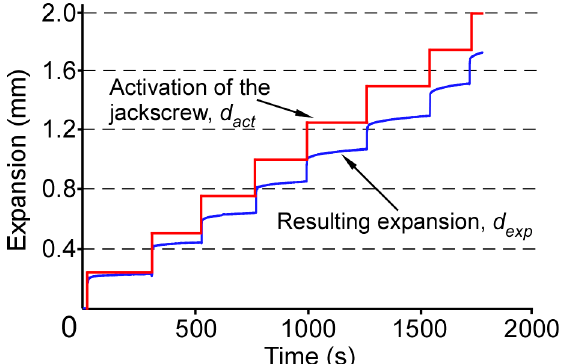
Figure 5. Comparison of the activation of the jackscrew ( d act ) and resulting expansion ( d exp ) as a function of time for eight turns of the jackscrew (2.0 mm total activation).